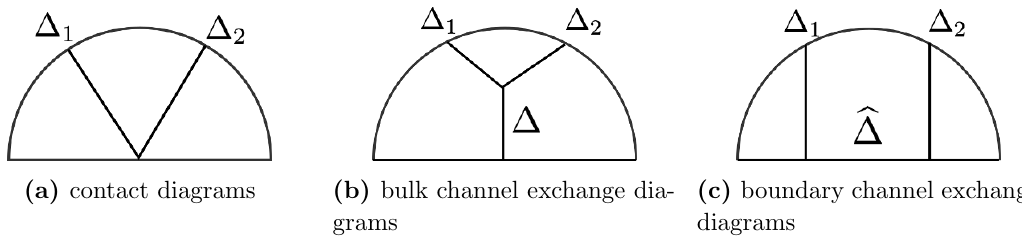
Figure 2. Tree level Witten diagrams in hAdS N which terminates at an AdS d , represented by the horizontal